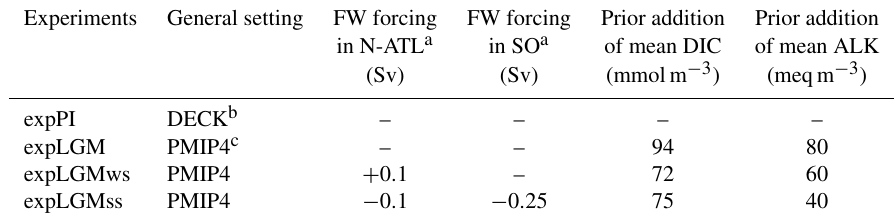
Table 1. Overview of the experimental designs in this study. Experiments